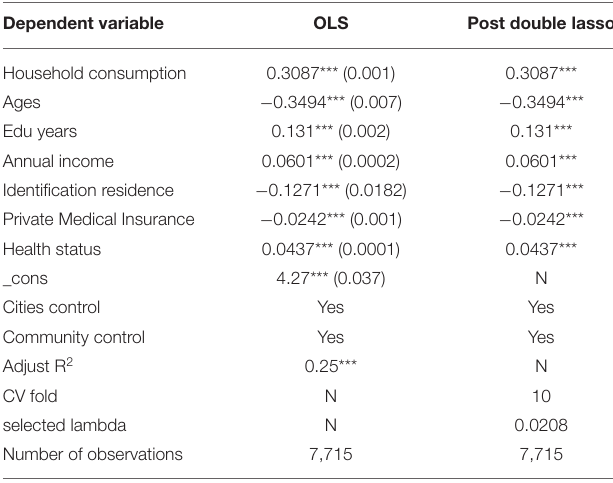
TABLE 2 | Lasso Regression of the relationship between health education and household